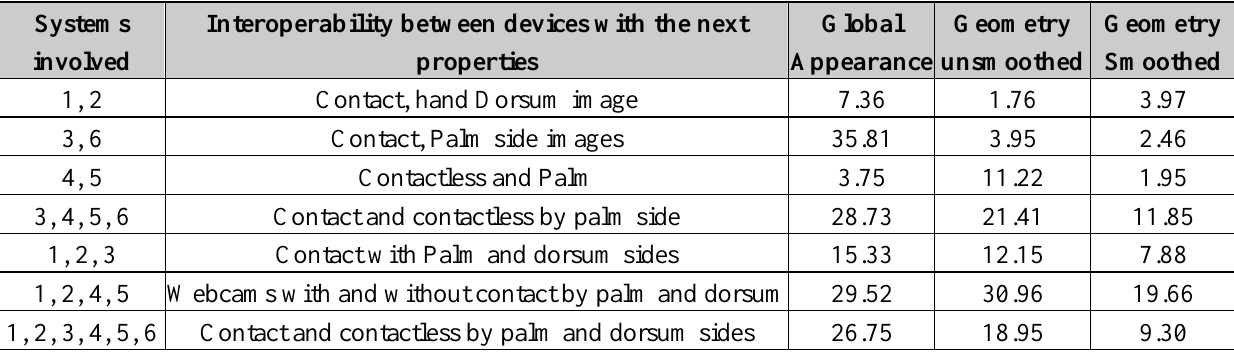
Table 7. Average Interoperability between different hand shape approaches in terms of EER